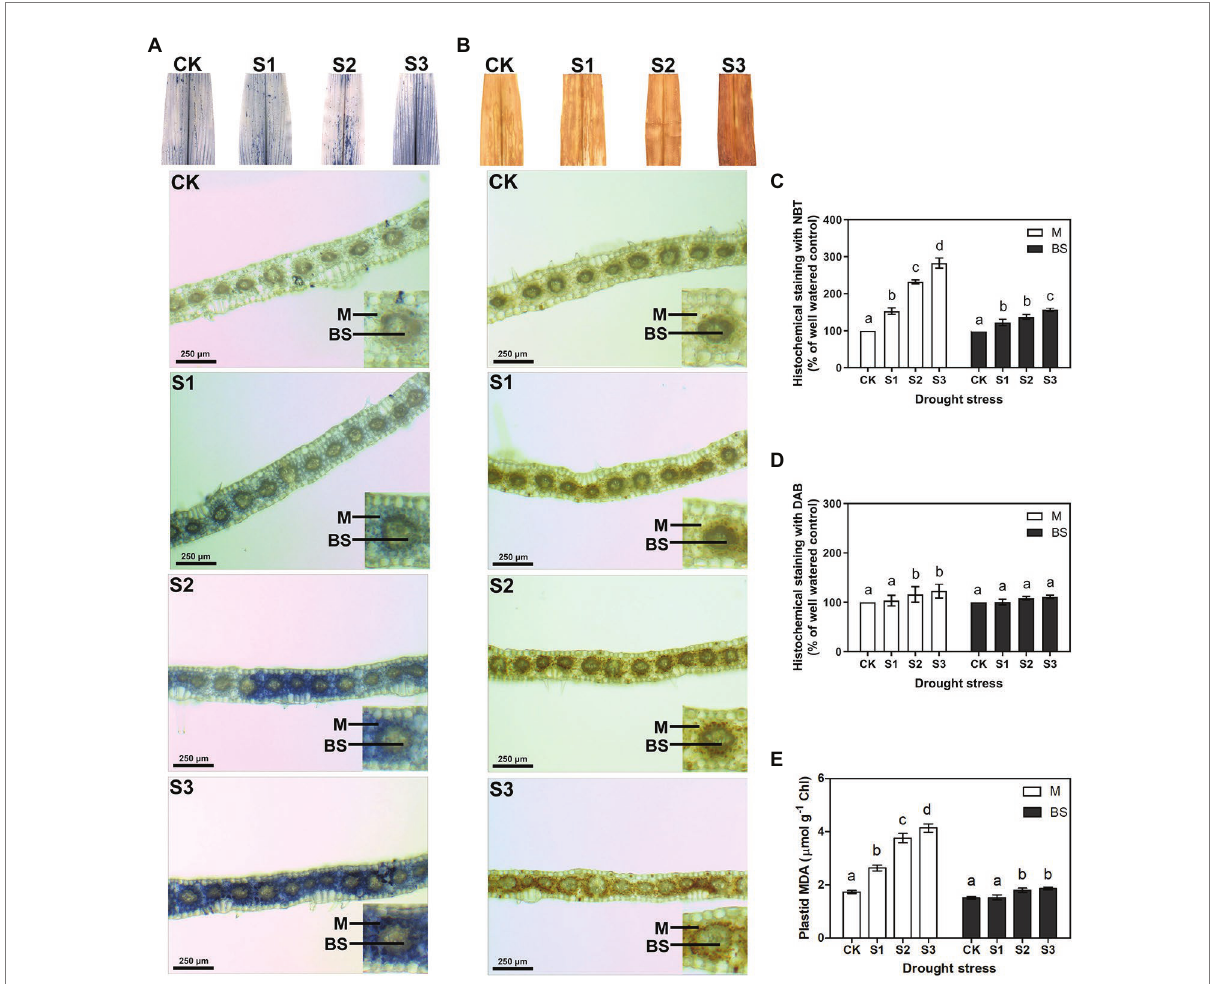
FIGURE 1 Measurement of reactive oxygen species (ROS) and lipid peroxidation in mesophyll (M) and bundle sheath (BS) cells of maize leaves under drought stress. Histochemical assays for O 2 − and H 2 O 2 in leaves by nitro-blue tetrazolium (NBT; A ) and 3,3-diaminobenzidine (DAB; B ) staining, respectively. Distribution of O 2 − and H 2 O 2 in M and BS cells were imaged in microscope. The microscopic images in M and BS cells were quantitative analyzed (C,D) . Plastid malondialdehyde (MDA) content ( E ) in M and BS chloroplasts of maize leaves were detected. CK, S1, S2, and S3 represent, respectively, the soil moisture regimes of well-watered, mild drought stress, moderate drought stress and severe drought stress. Values are expressed as the means ± SD from four independent biological replicates ( n = 4). Different letters depict significant differences between the treatments ( p < 0.05) according to Duncan’s multiplication range